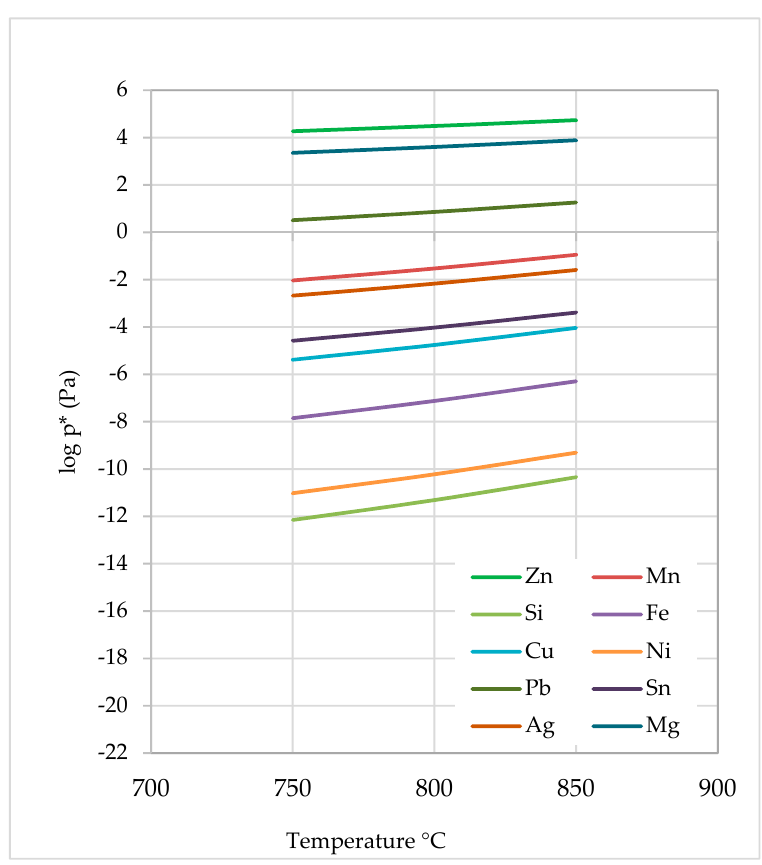
Figure 3. The variation of log p * versus temperature for Mg and selected impurities.